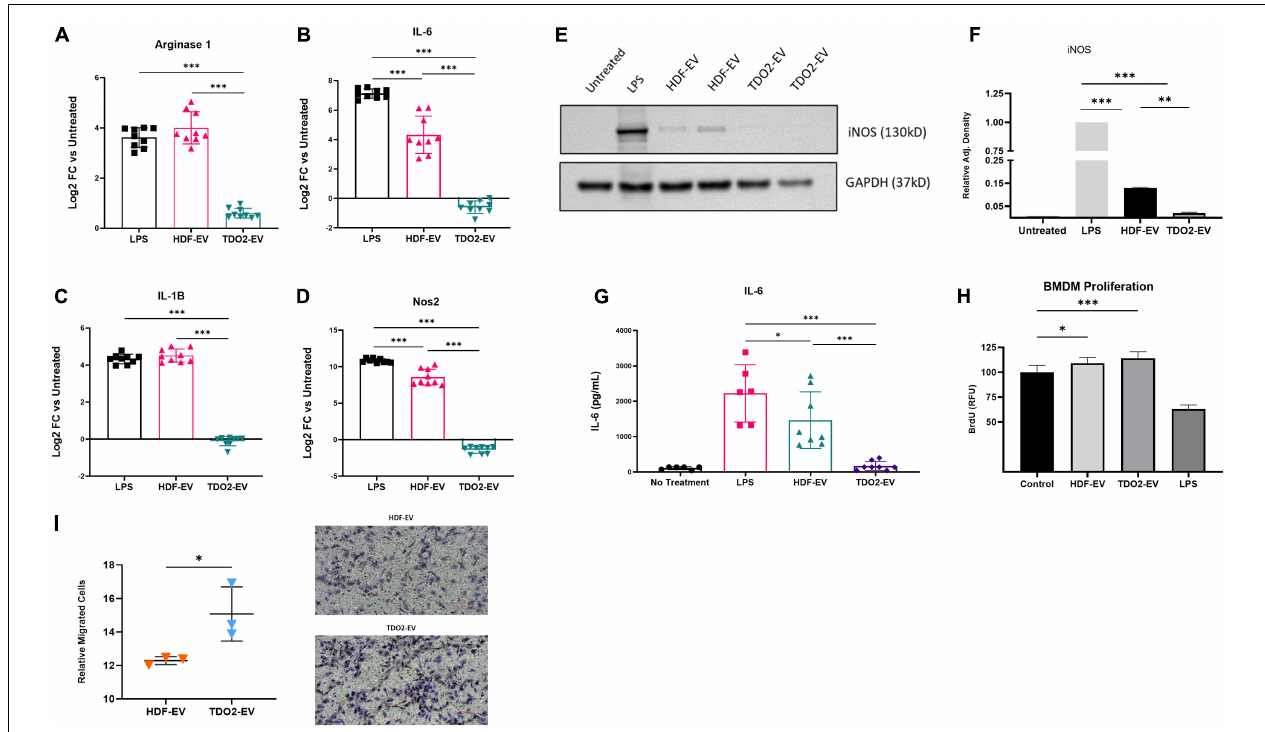
FIGURE 3 | nHDF TDO2 -EVs show anti-inflammatory function in bone marrow-derived macrophages. (A–D) Gene expression of inflammatory genes in BMDM cells after overnight treatment with nHDF or nHDF TDO2 EVs results graphed as log2 fold change versus untreated cells (not shown) ( n = 3 triplicates from three independent experiments). (E) Representative image of western blot detection of iNOS in BMDM cell lysates ( n = 2 from biological replicates). (F) Quantification of iNOS western blot images. (G) ELISA quantification of IL-6 in the cell culture conditioned medium of BMDMs treated overnight with nHDF-EV or nHDF TDO2 -EVs ( n = 3 triplicates from three independent experiments). (H) Proliferation of BMDM cells analyzed by colorimetric BrdU incorporation assay ( n = 8 technical replicates from a single experiment). (I) Results of modified Bowden-chamber assay for cell migration ( n = 3, 10 technical replicates; images from three independent experiments). (A–H) Analysis was done using one-way ANOVA with Sidek’s multiple comparisons test. (I) Analysis was done using an unpaired, two-tailed, t -test. All error bars represent standard deviation. ∗ p < 0.05, ∗∗ p < 0.01, and ∗∗∗ p <